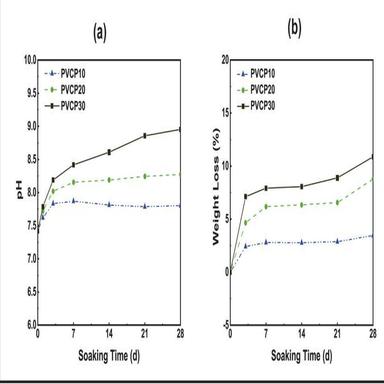
In the accompanying degradation study, the changes in the pH of SBF (a) and the scaffold weight (b) of CPS-PVDF scaffold immersed in SBF for up to 28 d.